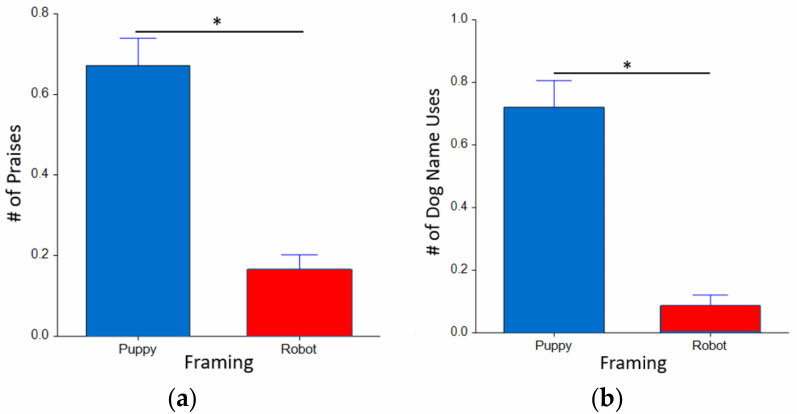
Figure 4. The average count of dog praises and dog name use across command blocks in each framing condition: ( a ) participants praised puppy Aibo more compared to robot Aibo; ( b ) participants used the dog name assigned significantly more while interacting with puppy Aibo, compared to robot